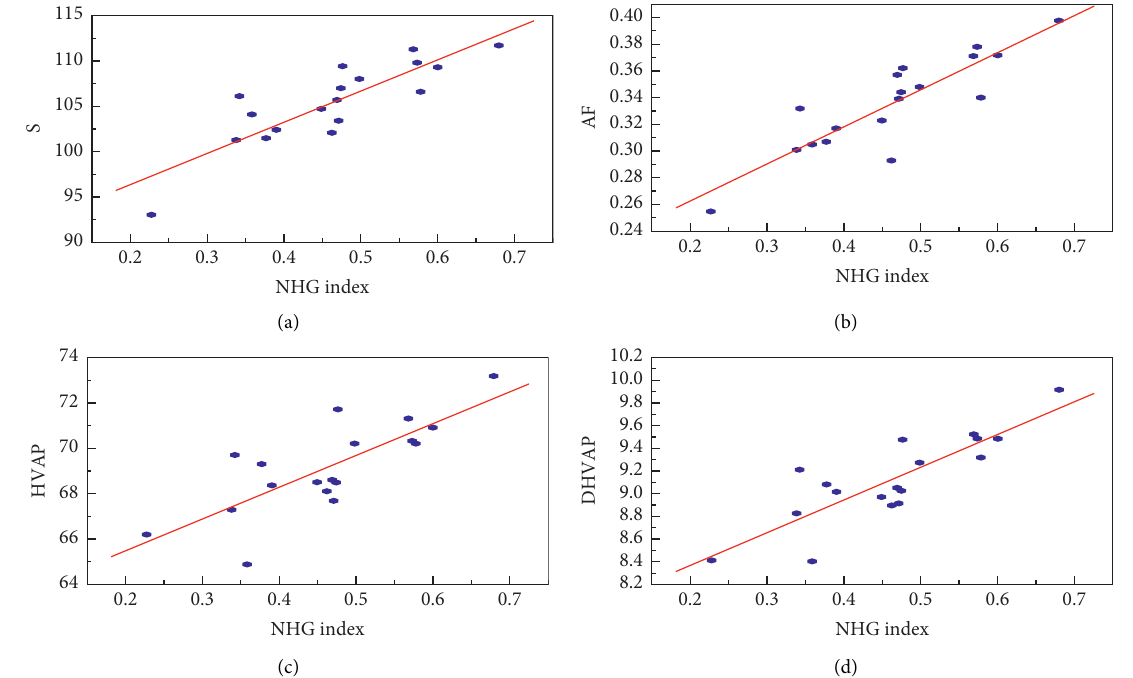
Figure 5: Scatter diagram of physical properties S , AF, HVAP, and DHVAP with the NHG index.